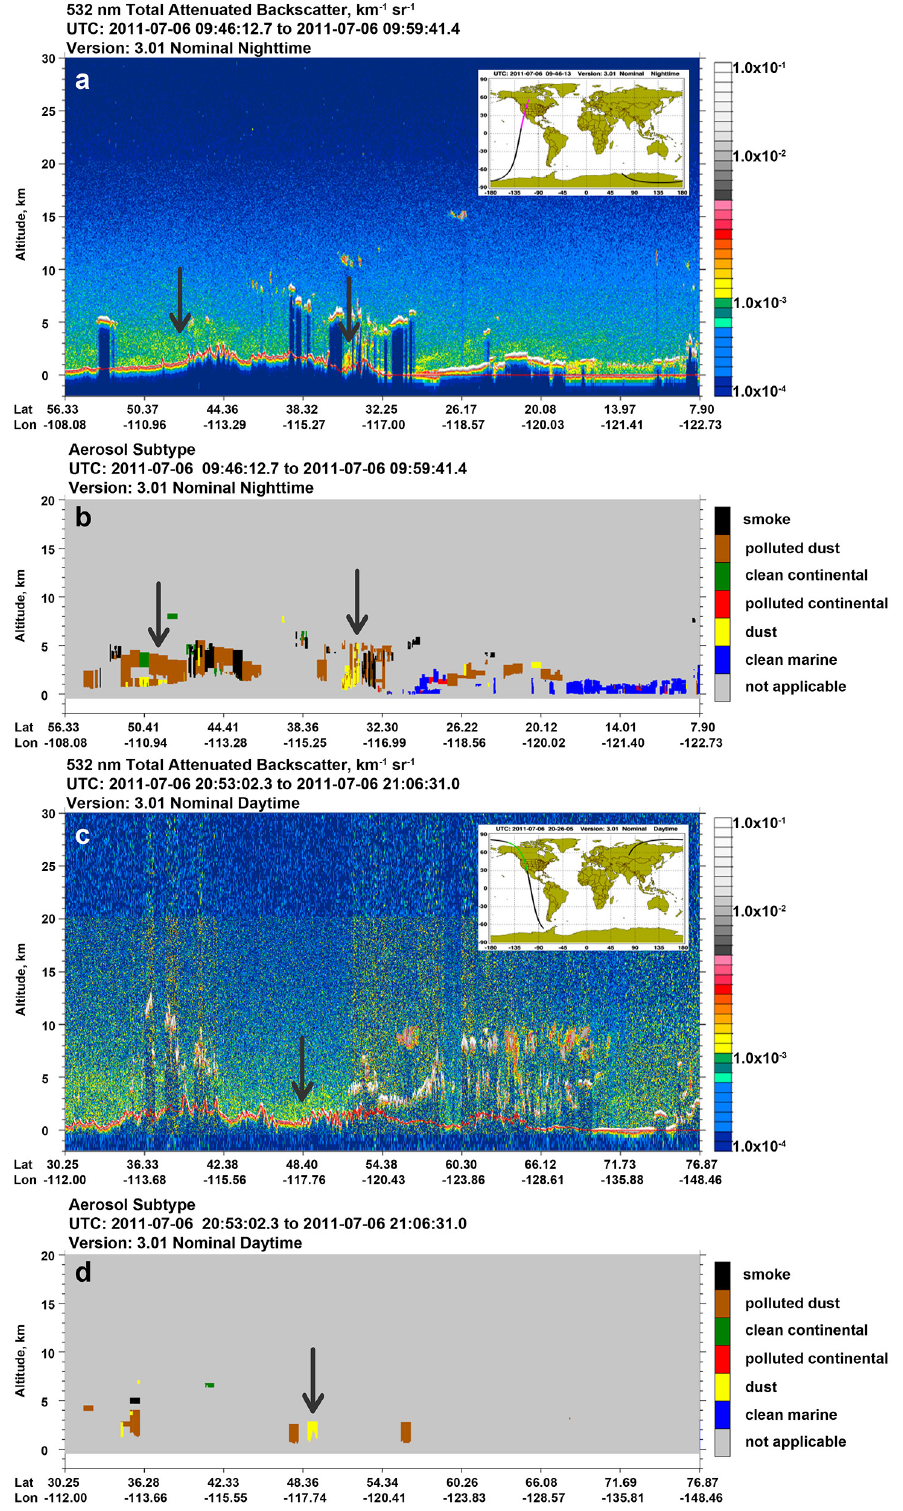
Fig. 11. Satellite observations of haboob event 6 July 2011 showing total attenuated backscatter at 532nm of a dust event as measured by (a) the nighttime CALIPSO overpass (at 09:46 to 09:59UTC) and (c) the daytime CALIPSO overpass (at 20:53 to 21:06UTC) and CALPSO aerosol subtype at (b) nighttime and (d) daytime. The inset map shows the path of CALIPSO overpass over the globe (black line) and the study region (magenta “night” and green “day”